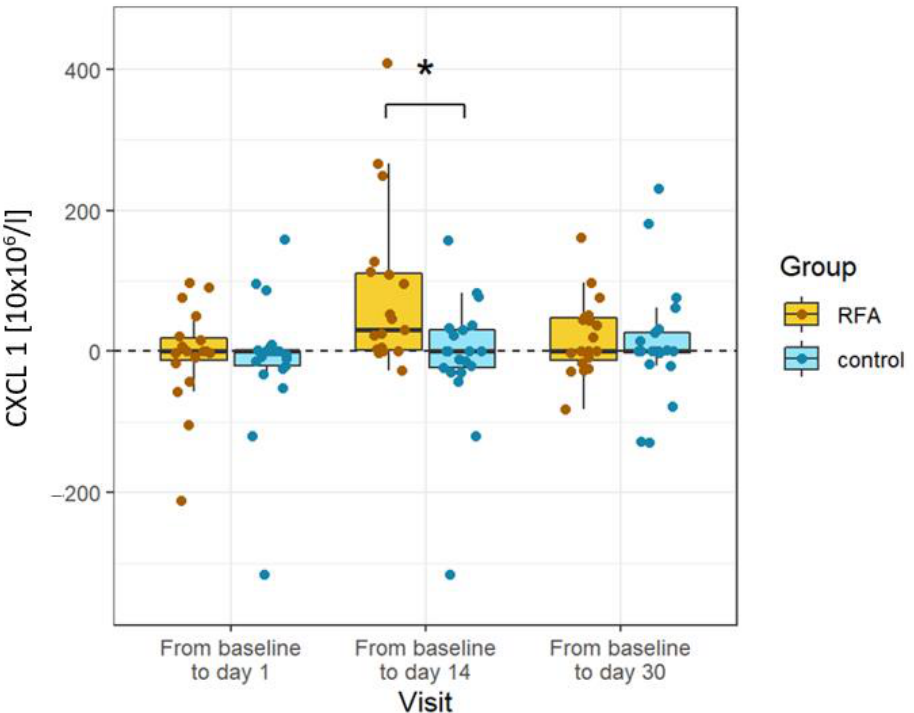
Figure 3. Changes in cytokines specific to RFA. CXCL1 was significantly elevated in the RFA-treated patients compared to the controls on day 14. Absolute differences from baseline are plotted for different visits using box and whisker plots. The line in the middle of the box represents the median; the upper and lower ends of the box represent the first and third quartiles, respectively. The upper and lower whiskers show the maximum and minimum scores, respectively, excluding outliers. Individual dots represent individual patients’ values. Asterisks show the statistical significance.